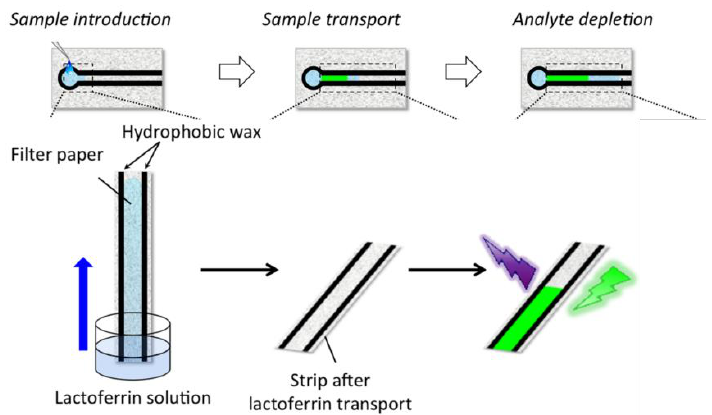
Figure 4. Scheme of detecting process of distance-based microfluidic paper device (reprinted with permission) [114] . permission)